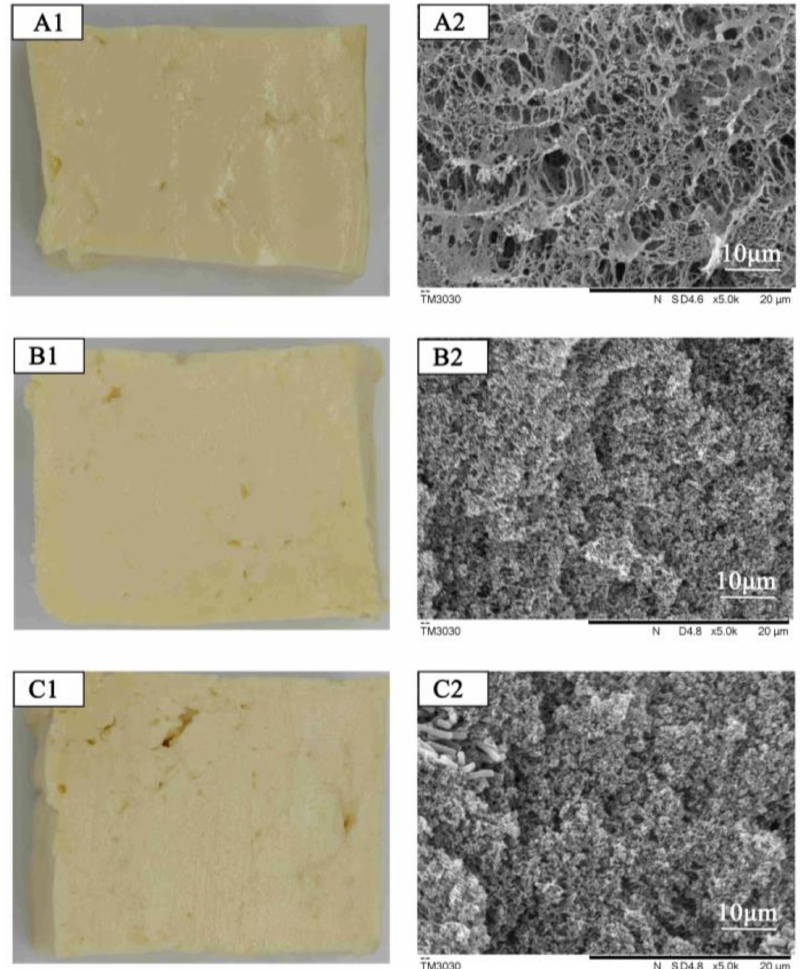
Figure 5. Pictures of tofu manufactured from coagulants fermented by L. paracasei ( A1 ), L. plantarum ( B1 ), and natural bacteria ( C1 ). SEM images of tofu manufactured from coagulants fermented by L. paracasei ( A2 ), L. plantarum ( B2 ), and natural bacteria ( C2